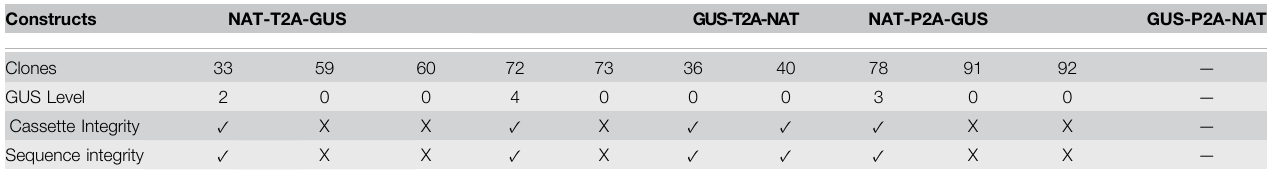
TABLE 1 | The phenotypic and genotypic characterization of single-copy transgene clones (CLOSITRA). For each clone, the level of GUS intensity relative to the GUS5- positive control (Row 3), the cassette integrity information measured after PCR analysis of the region surrounding the polycistronic cassette from the FcpB promoter to the FcpA terminator ( Supplementary Figure S9 ) (Row 4), and the result for the amplicon (Row 5) are indicated.